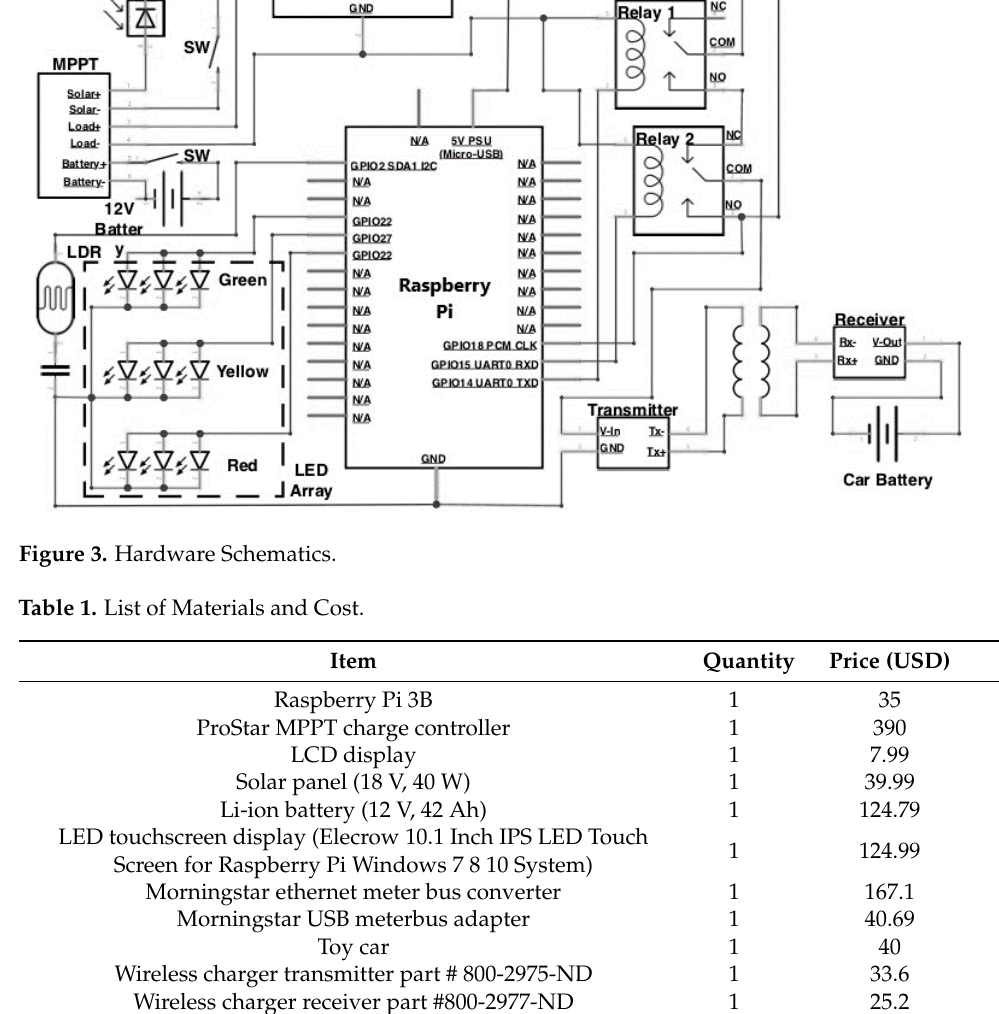
Figure 3. Hardware Schematics.